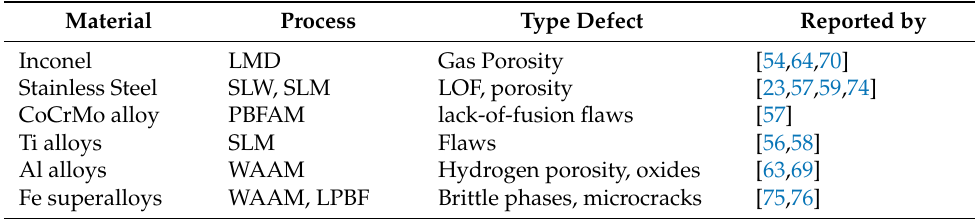
Table 2. Major reported defects of various metallic systems processed by